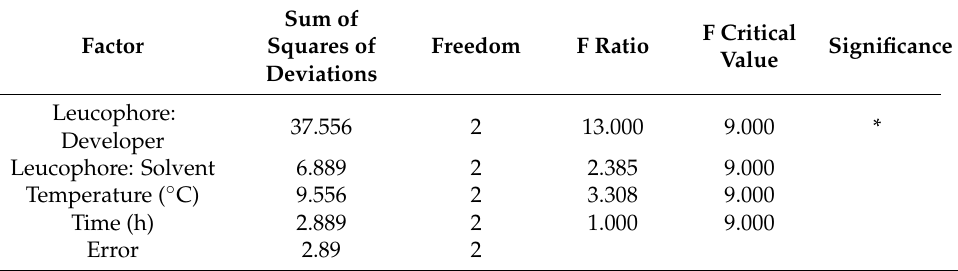
Table 6. Analysis of variance table.